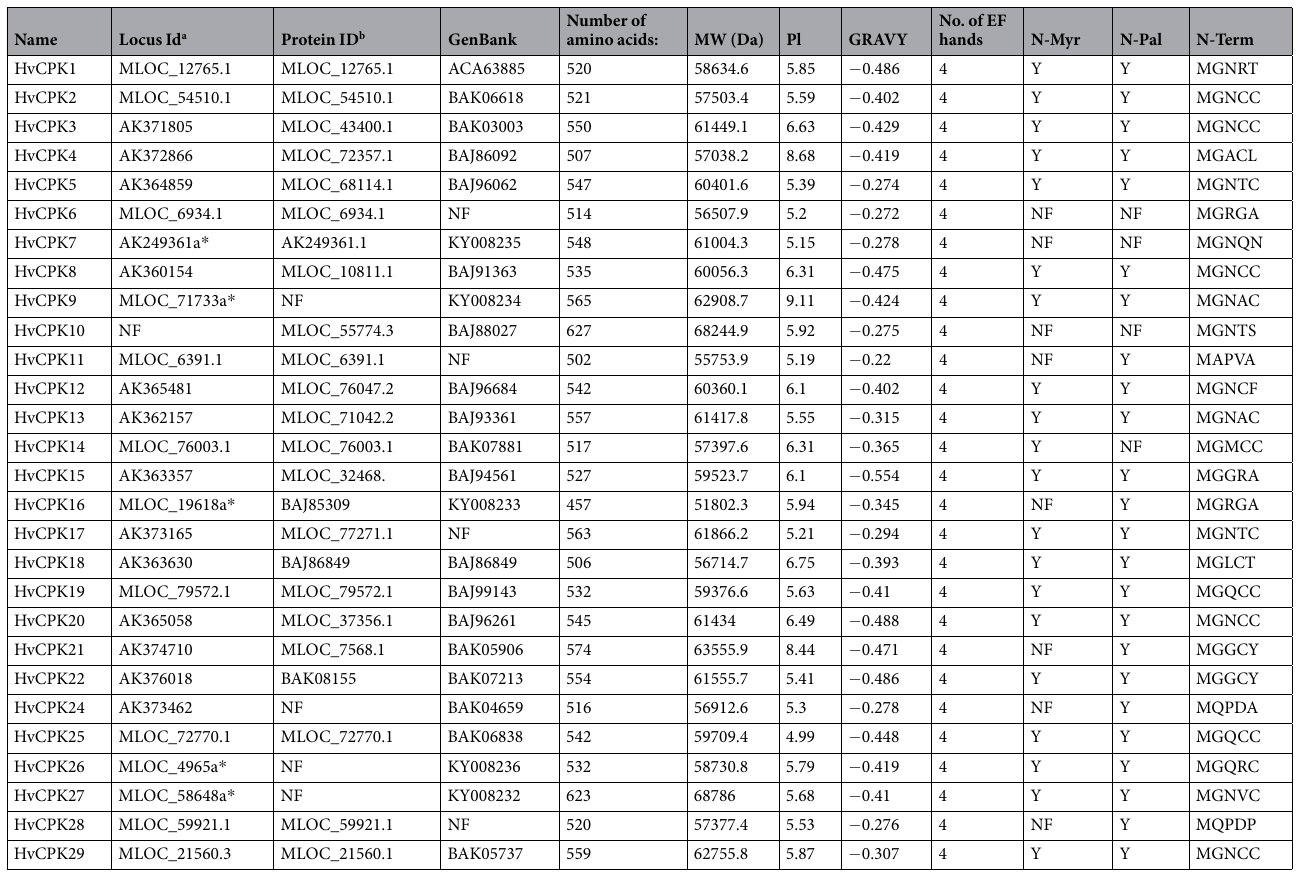
Table 2. CDPK genes identified and cloned from barley. * Newly cloned CDPK gene; a PGSB-PlantsDB database; b Hordeum vulgare at Ensembl Plants; NF, Not